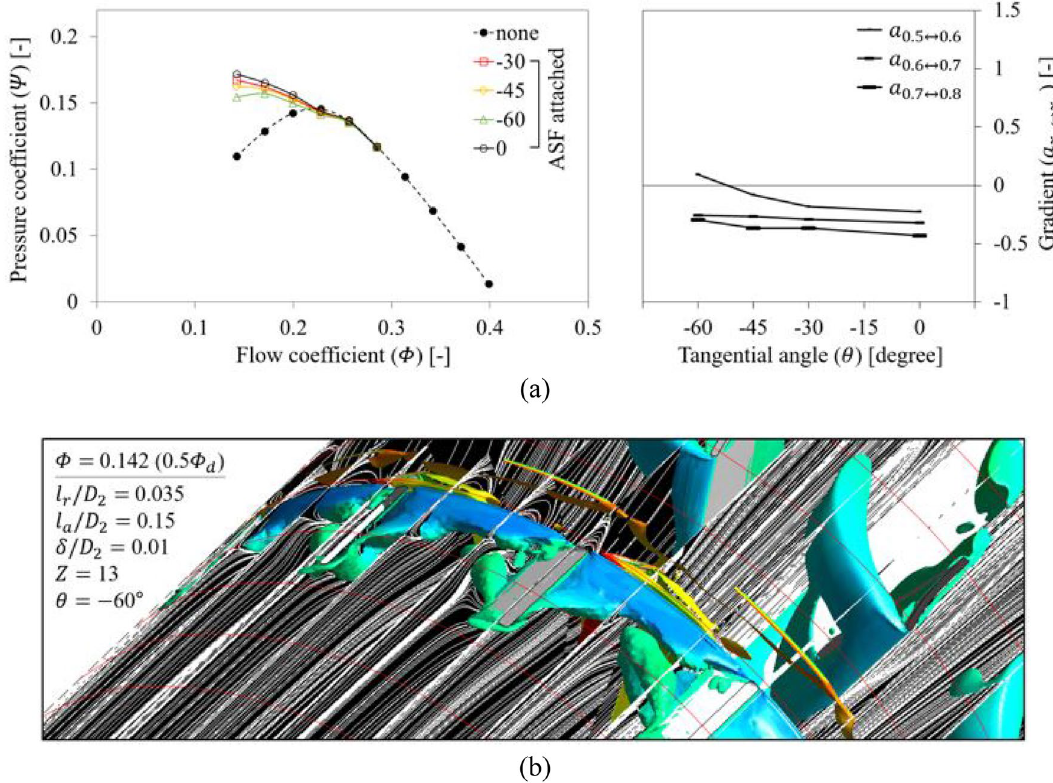
Figure 19. Evaluation for negative-tangential angle ( − θ ) of ASF: ( a ) Q – P curve (left) and the gradient (right) in each flow rate range; ( b ) Internal flow field for θ = − 60° at 0.5 Φ d .